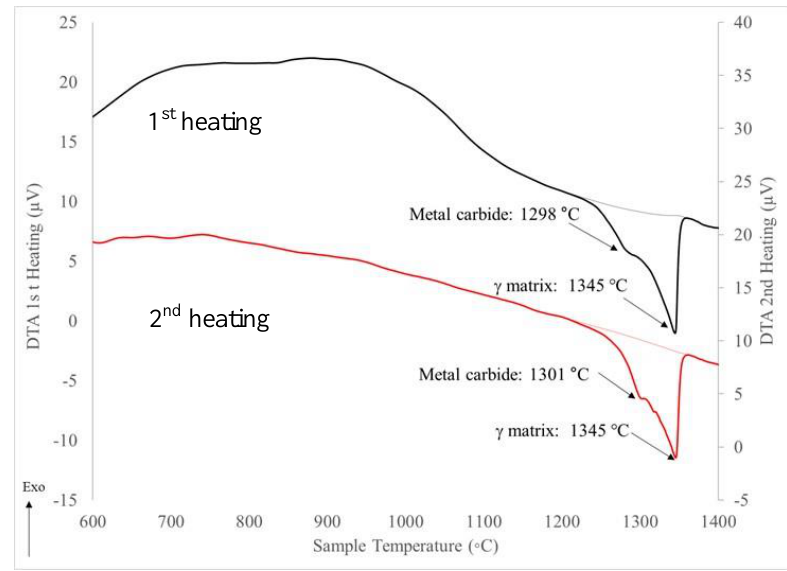
Figure 11. DTA heating cycles for DA Inconel 718.